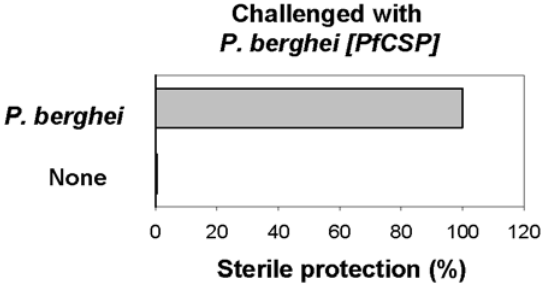
Figure 5. Sterile protection in [BALB/c 6 C57BL/6] F1 mice immunized three times with P.bergheior P.berghei[PfCS] and challenged with 5000 P.bergheior P.berghei[PfCS] sporozoites. All animal groups (5 mice per group) were monitored for blood-stage infections by examination of Giemsa-stained blood smears obtained daily from day 2 to day 11 post-challenge. All naive control mice developed a patent blood-stage infection.